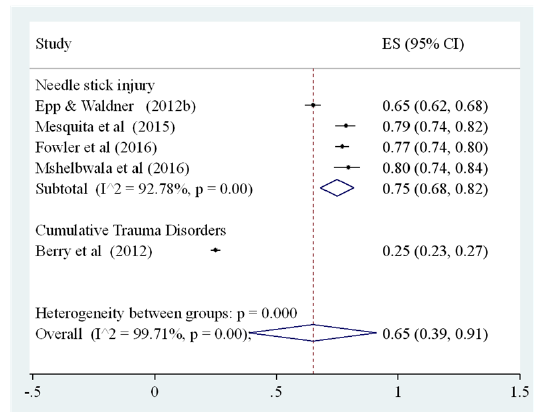
Figure 5 Forest plot of pooled prevalence of physical hazards among